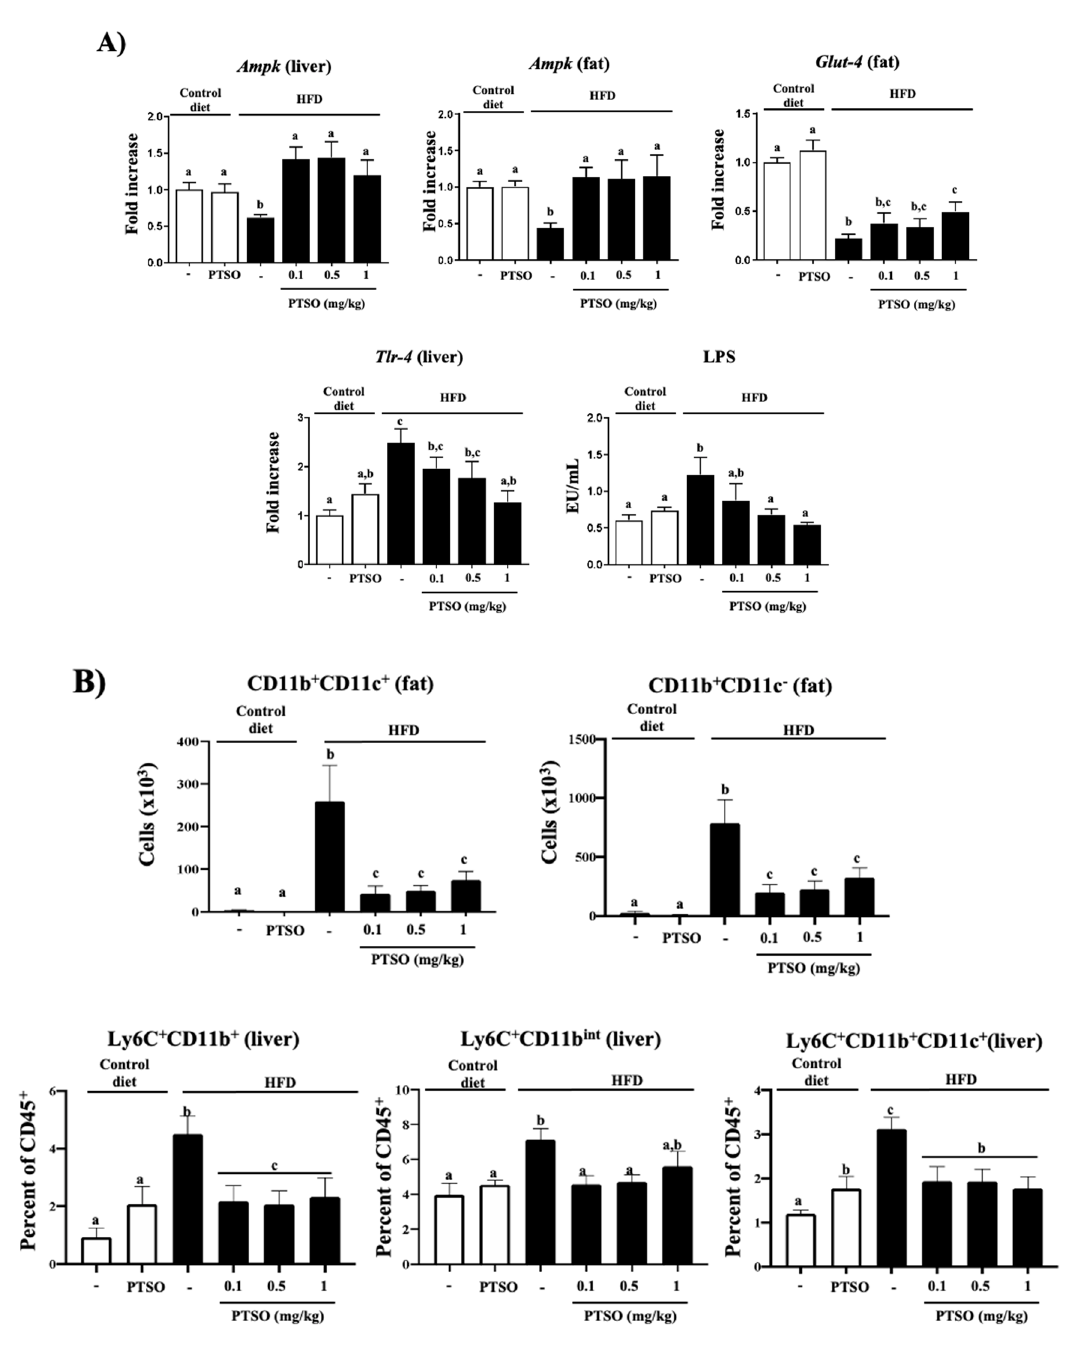
Figure 5. Effects of propyl propane thiosulfonate (PTSO) administration on the liver and fat: ( A ) gene expression of Ampk , Glut4 and Tlr4 , which was analyzed using real-time qPCR and LPS plasma concentrations; ( B ) infiltration and composition of the immune population in control and high-fat diet (HFD)-fed mice. Groups with different letters statistically differed ( p < 0.05).